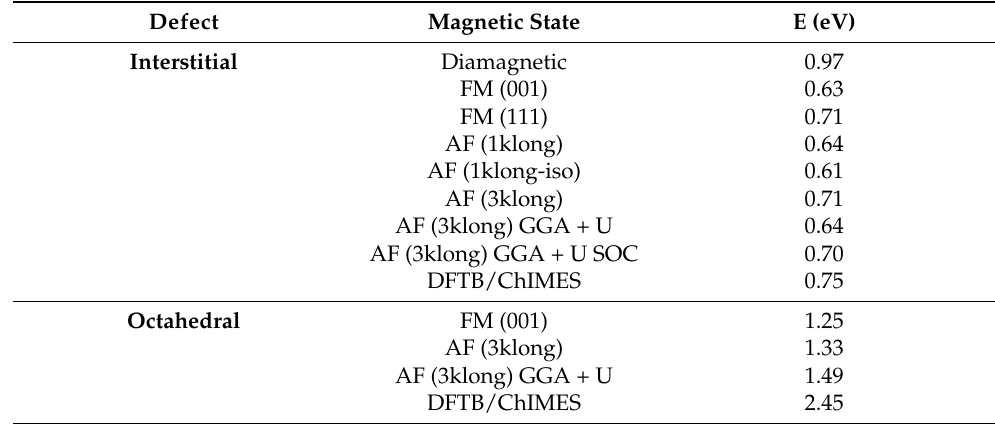
Table 3. Hydrogen interstitial and octahedral site formation energies from PBESol. Calculations were performed with SP only and exclude GGA + U and SOC unless otherwise noted. The AF (1klong) calculations was performed on the tetargonally distorted lattice, whereas the AF (1klong-iso) calculation was performed with the cubic experimental